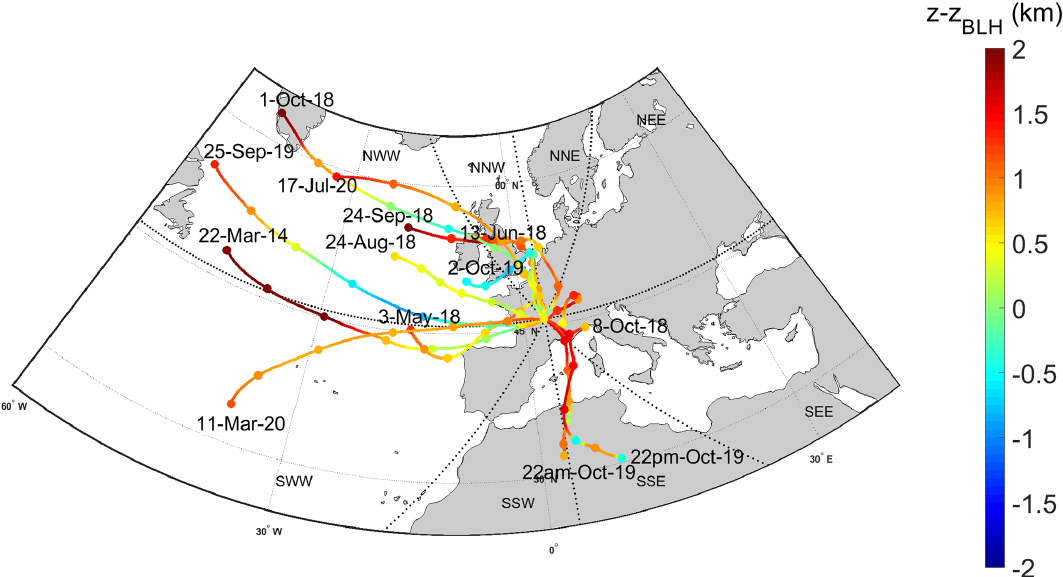
Figure 1. Back-trajectory plots of air masses reaching the PUY. Colors correspond to the air mass height minus the atmospheric boundary layer height (ABLH). Positive values ( > ABLH, red) indicate the air mass is in the free troposphere. Negative values ( < ABLH, blue) indicate the air mass is within the boundary layer. Each trajectory plot is the mean value of a cluster of 45 CAT trajectories calculated over 72h, every hour from the beginning to the end of the cloud sampling period. Trajectory points are calculated every 15min, and dots in the figure indicate 12h intervals. All the trajectory clusters (without averaging) for each of the 13 events are given in Fig. S4.